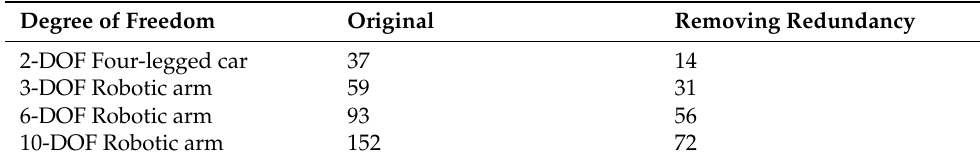
Table 1. HDPP waypoint effect in high-dimensional